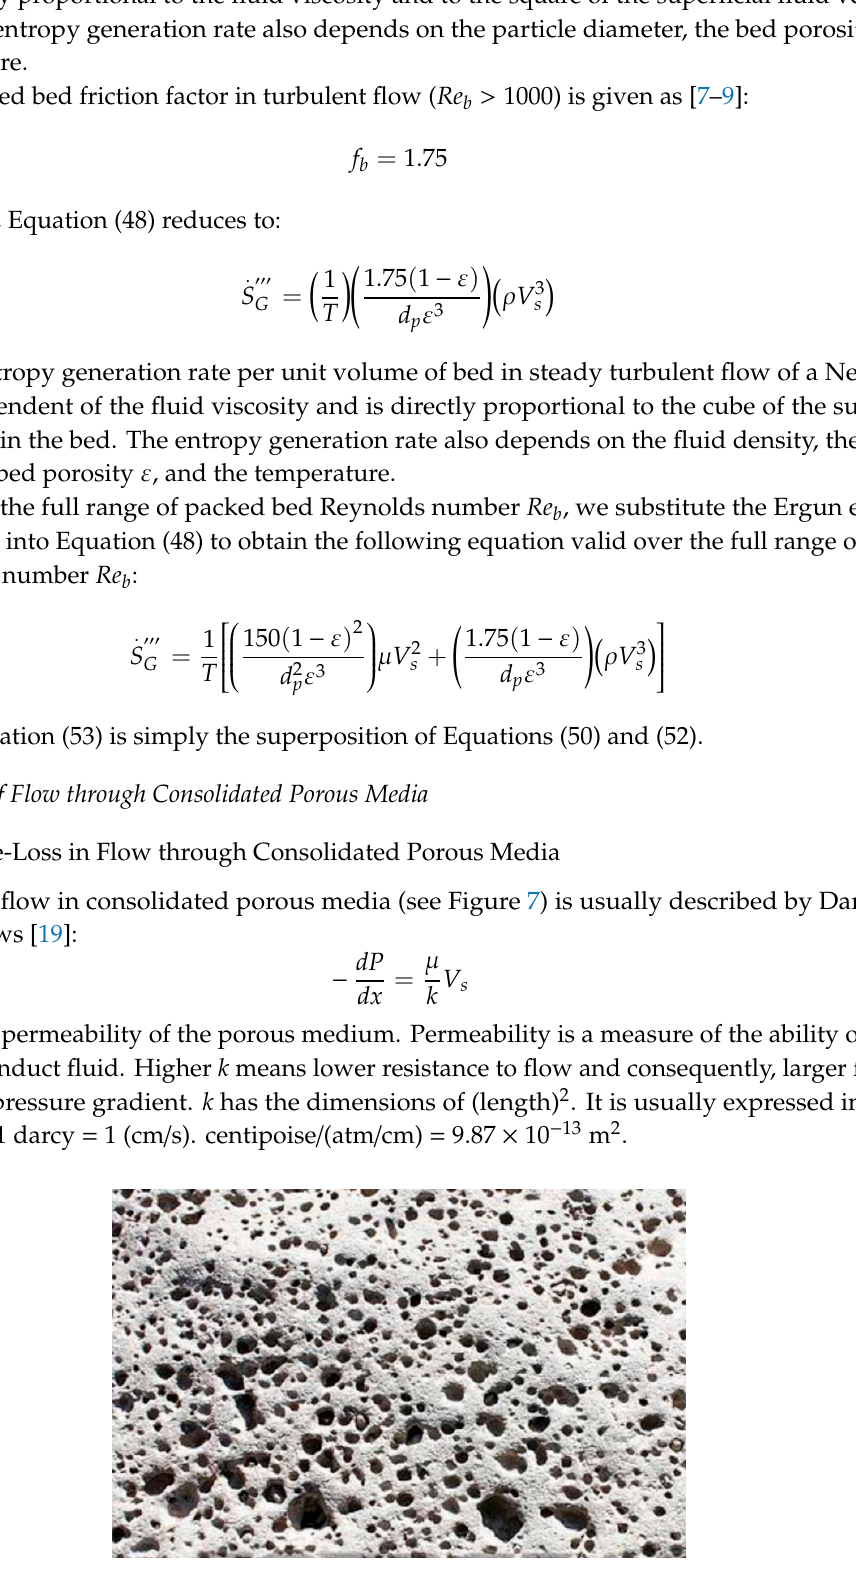
Figure 7. Consolidated porous medium (adapted from